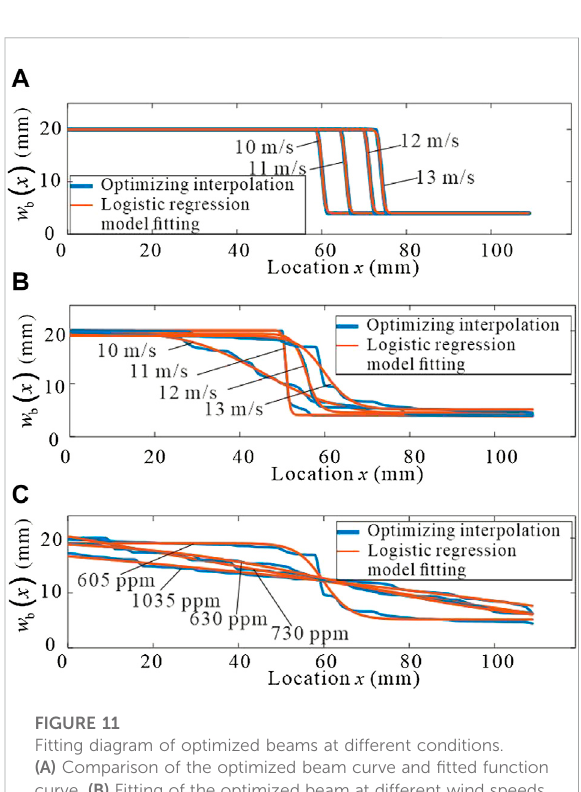
FIGURE 11 Fitting diagram of optimized beams at different conditions. (A) Comparison of the optimized beam curve and fi tted function curve. (B) Fitting of the optimized beam at different wind speeds. (C) Fitting diagram of optimized beams at different strain upper